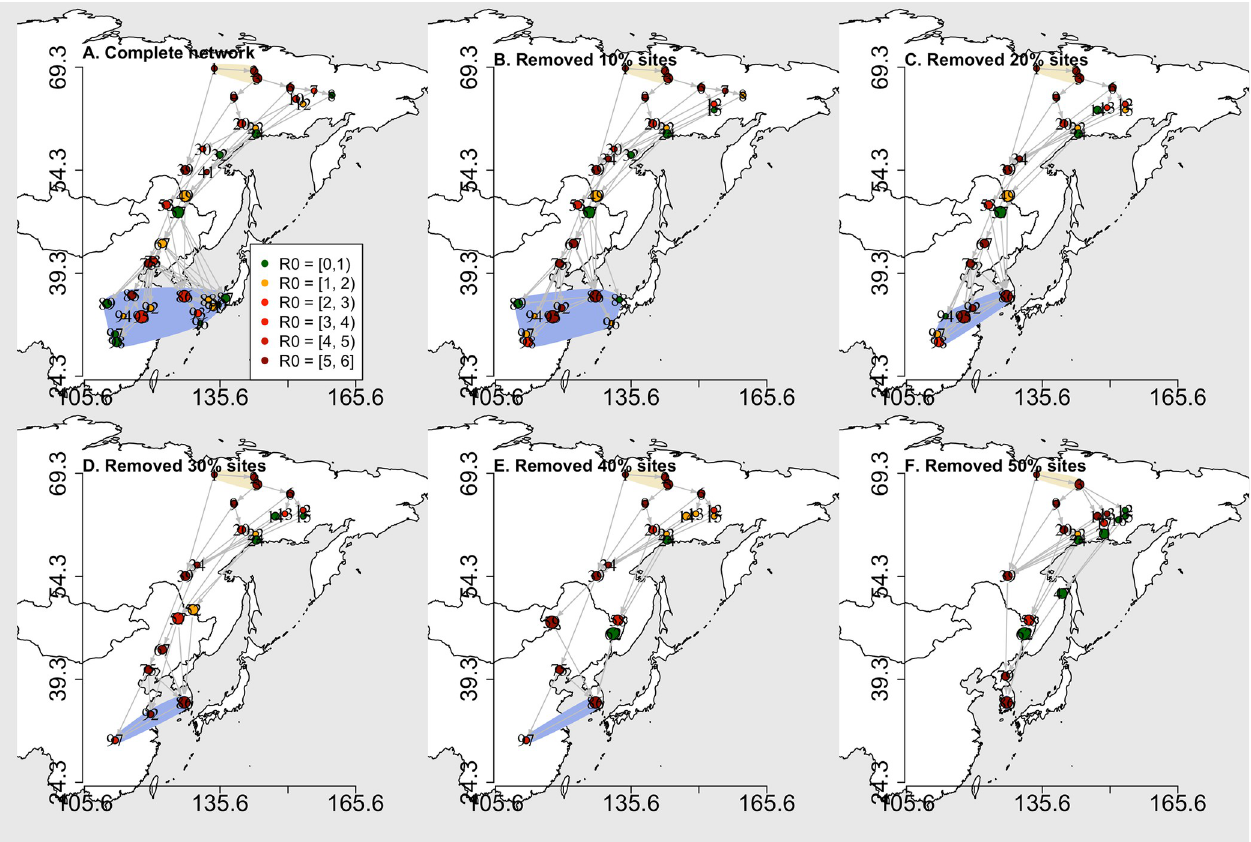
Fig 1. The visited migration networks generated by the simulated geese movement according to the agent-based model. A) the complete network, and B-F) the network scenarios of 10%, 20%, 30%, 40% and 50% site removal. Dots are sites visited by geese, colors represent the maximum R 0 that occurred at sites during the simulation, and numbers are site IDs. Yellow and blue shadows depict breeding and wintering regions. The base layer maps were generated in R environment using the “maps” package (Original S code by Richard A. Becker, Allan R. Wilks. R version by Ray Brownrigg. Enhancements by Thomas P Minka and Alex Deckmyn. (2016). maps: Draw Geographical Maps. R package version 3.1.1.